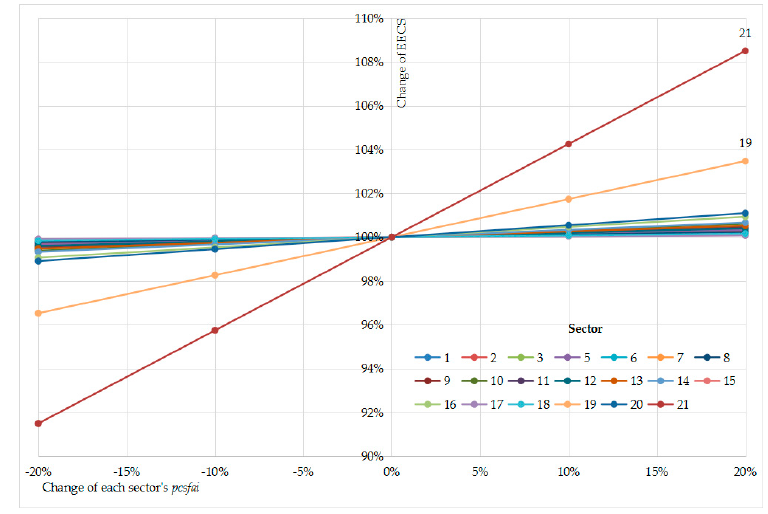
Figure 8. Sensitivity analysis of pcsfai i .